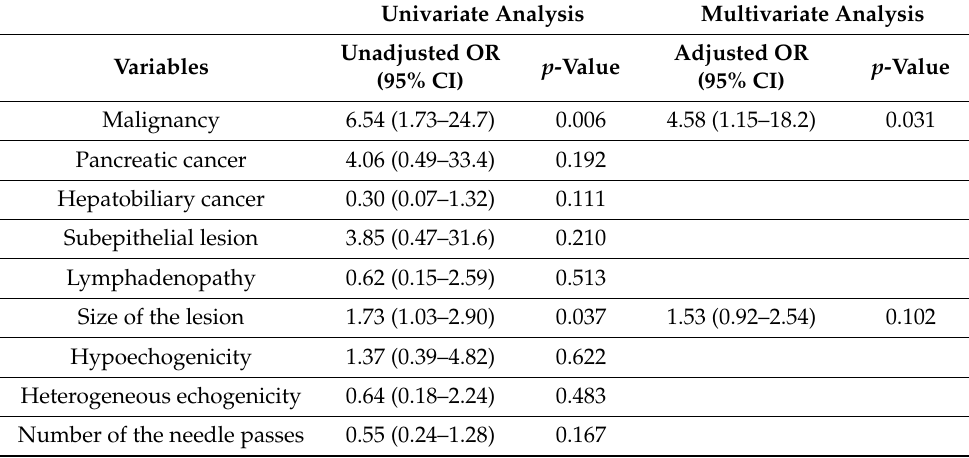
Table 4. Factors associated with tissue adequacy. Univariate Analysis Multivariate